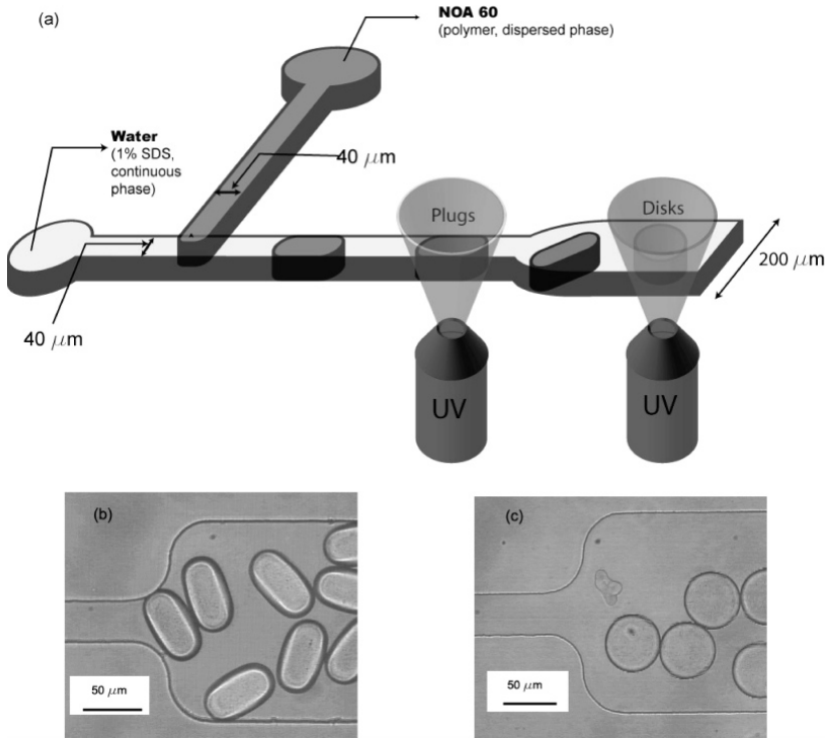
Figure 27. Microchannel geometry used to create plugs and disks: ( a ) schematic of channel with plug and disk creation zones marked; ( b ) polymerized plugs in the 200 µm section of the channel, 38 µm height; ( c ) polymerized disks in the 200 µm section of the channel, 16 µm height [42].